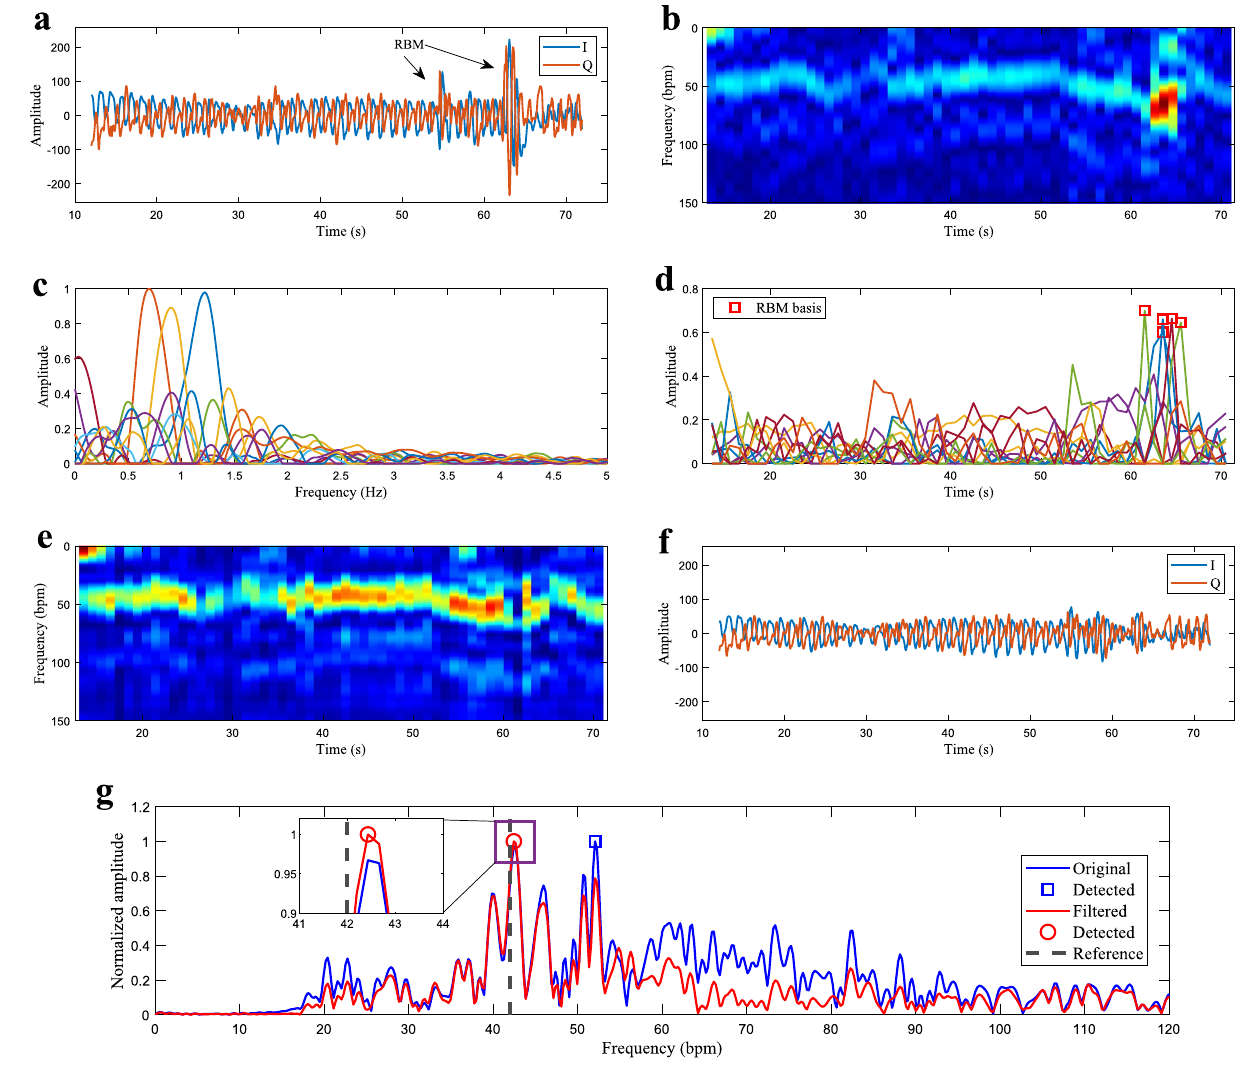
Figure 4. NMF for random body motion mitigation. ( a ) I and Q samples of the displacement signal x ( t ), corrupted by RBM. ( b ) Normalized spectrogram | X | . The RBM interference clearly dominates the spectrum and would jeopardize estimation. ( c ) NMF decomposition into the frequency basis components in W . ( d ) NMF decomposition into the time basis components in H . ( e ) RBM filtered spectrogram ˆ| X | . ( f ) I and Q samples of the RBM filtered time signal ˆ x ( t ) . ( g ) Bandpass spectrum of the original and RBM filtered the spectrogram is calculated based on the complex samples of the recovered signal x ( t ), and therefore considers 11 frequency ( W ) and time basis ( H ) both I and Q channels simultaneously. The NMF decomposition into K = components is depicted in Fig. 4c,d, where each color represents a pair of basis components, with the frequency content in Fig. 4c, and the corresponding time activation in Fig. 4d. It can be seen that (please refer to the green and blue bases for instance), due to its random nature, the RBM interference has frequency components spread over the entire spectrum, overlapping with the breathing frequency region. While a variety of frequencies can be visualized in W , the sparse and strong bases corresponding to RBM can be clearly identified in H (please refer to the Methods). Removing the selected bases allows the reconstruction of the filtered spectrogram in Fig. 4e, where the breathing frequency variation over time (around 45 bpm) is now evident. After the inverse STFT, the RBM filtered time signal is depicted in Fig. 4f. Finally, Fig. 4g shows the bandpass spectrum of both the original and the RBM filtered signals. The corresponding detected values are highlighted respectively with the blue and red markers. The dashed black line shows the reference value for the average breathing frequency associated with this processing window. Because of the strong RBM interference, the maximum value of the original spectrum would indicate an erroneous breathing frequency of 52.1 bpm, very distant from the true value of 42 bpm. After RBM filtering with the NMF, the modified spectrum indicates a closer value of 42.4 bpm, where the estimation error would be only 0.4 bpm.